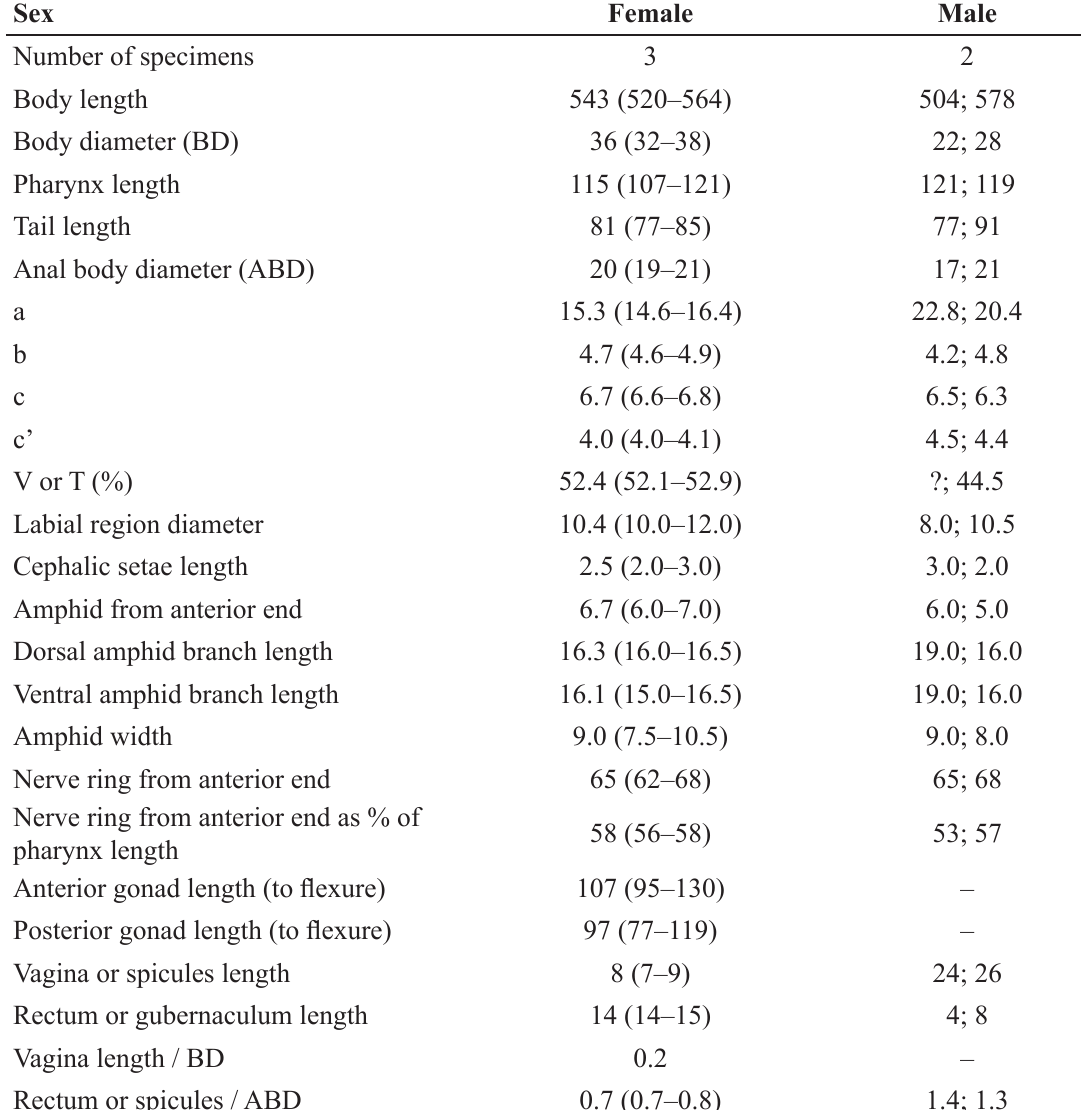
Table 5. Measurements (in µm) of Diplopeltoides pumilus (Vincx & Gourbault, 1992) comb. nov., presented as mean and (range) for females and and each male individual measurement separated with a semicolon; “?” indicates that the character can not be observed or